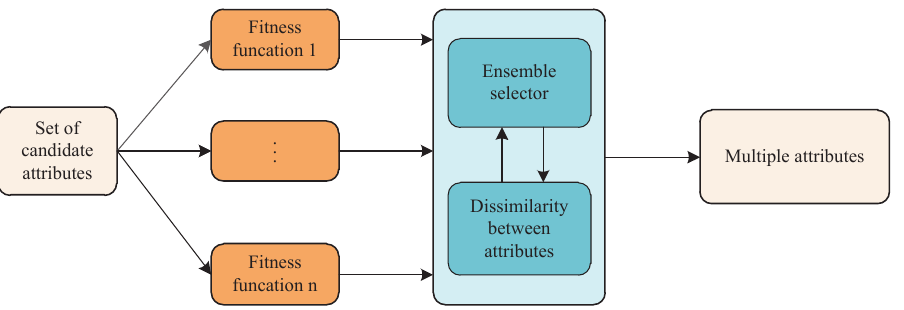
Figure 1. The framework of hybrid